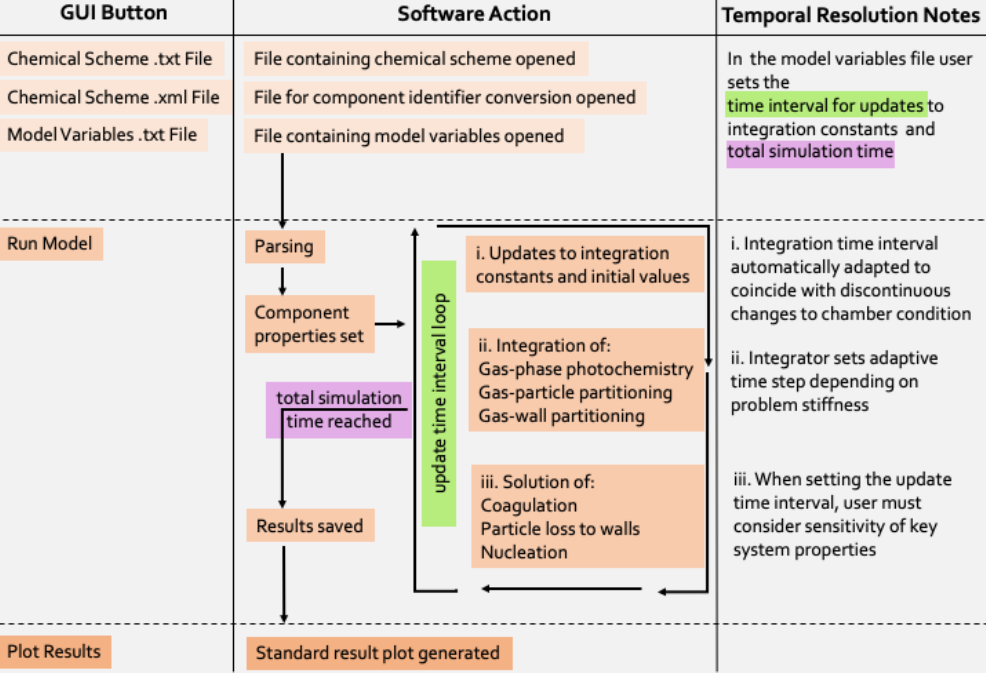
Figure 2. Schematic outlining the PyCHAM structure. In the left column are the GUI buttons that initiate the action(s) in the central column. On pressing the “run model” button PyCHAM loops over the “update time interval” until the experiment end time is reached. On each loop PyCHAM first checks whether any discontinuous changes to the chamber condition occur during the proposed time interval and automatically reduces the interval if confirmed such that the change can be implemented at the correct time at the start of the subsequent interval. Depending on problem stiffness the integrator uses sub-time steps, with the model taking the result at the end of the integration period. The final stage of a loop wherein the update time interval has been reached is the solution of coagulation, particle deposition to walls and nucleation, which update the particle number concentration. The right column notes these temporal resolution aspects, with the mentioned sensitivity of key system properties investigated in Sect.